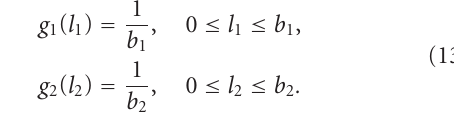
& μ ∗ ) on parameters I o